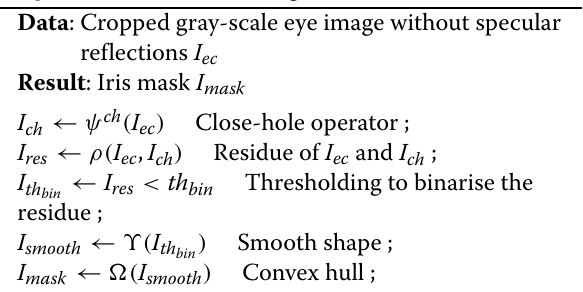
Algorithm 2: Precise iris segmentation